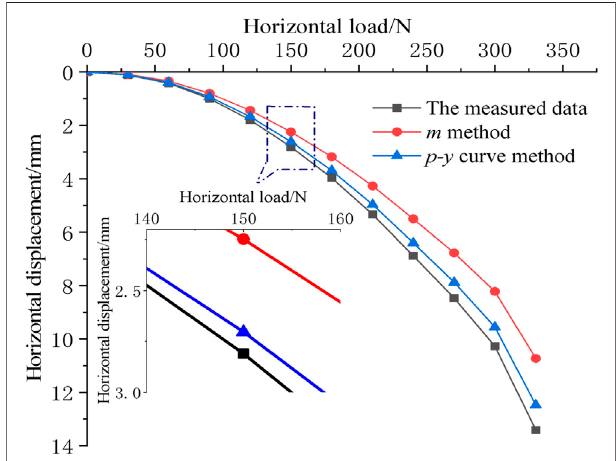
FIGURE 13 | Measured and calculated load – displacement curves of model tests under horizontal static